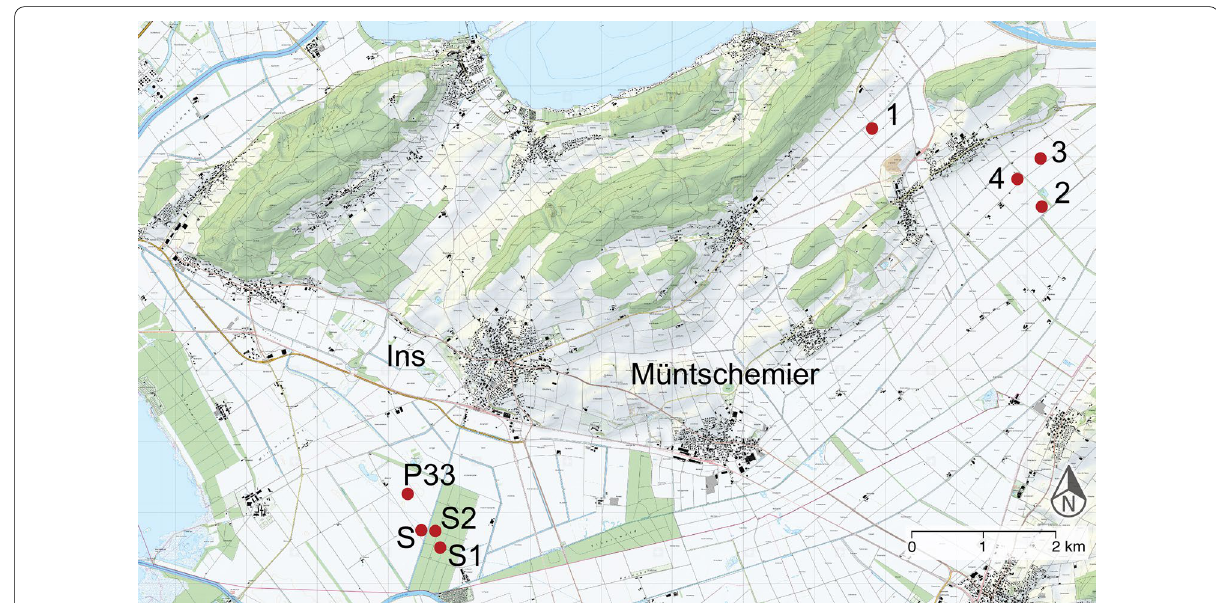
Fig. 4 Location of the investigated profiles. S1 and S2 are in a forest (Staatswald), P33 and S are in the adjacent agricultural land (Lienert 2013). These sites lie within the former extension of Lake Neuchâtel. Site 1 is western of the main plain (Grosses Moos) in the area of a former lake. Sites 2–4 are in the main plain (Grosses Moos) that has been affected by the Aare river (Source: LK 25